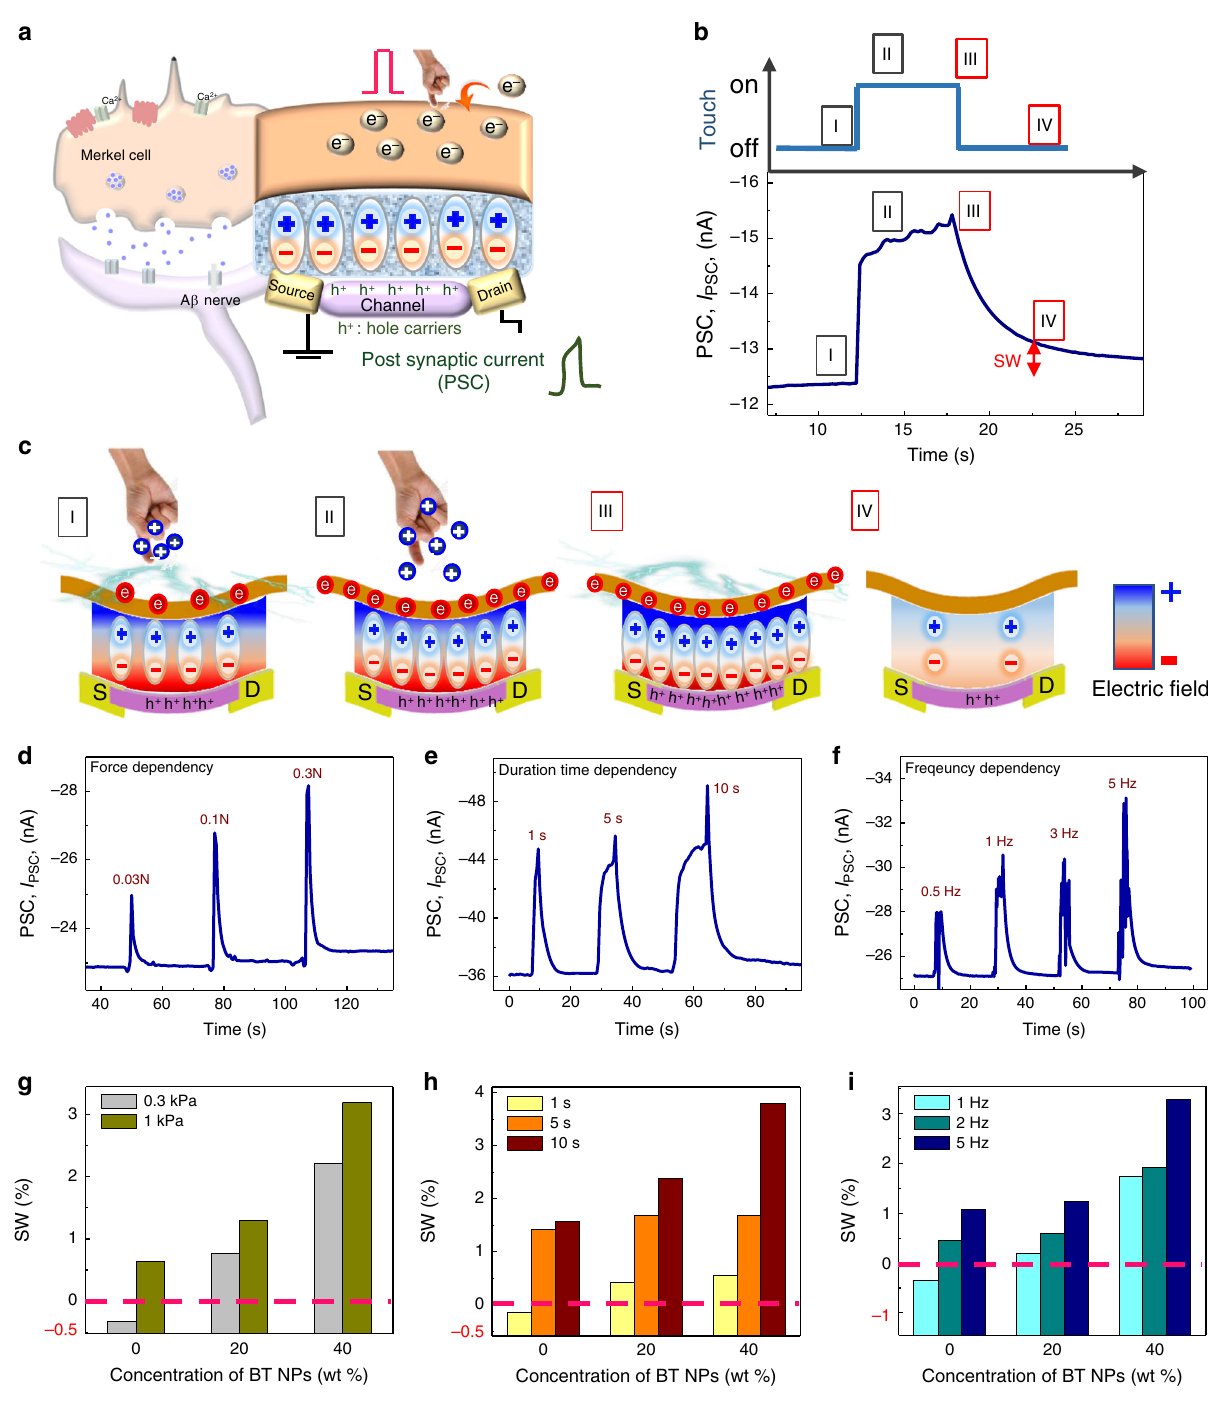
Fig. 3 Structure, mechanism, and synaptic properties of the AiS-TSO. a Sketch of device structure corresponding to a Merkel cell and MCNCs structure. b PSC during a tactile stimulus ( ≈ 0.3 kPa). A continuous bias of – 3 V was applied to the drain electrode to read the PSC. c Schematic explanation of dipole switching in the ferroelectric layer and accumulation of hole carriers in the channel induced by tactile stimulation. Illustration of the state of I – IV of b and principle of formation of P r with a change in channel conductance corresponding to SW. d Relative changes in the PSC of the AiS-TSO at different pressures. e Dependence of the PSC of the AiS-TSO on touch duration ( ≈ 1 kPa). f Dependence of the PSC of the AiS-TSO on touch rate ( ≈ 1 kPa for 5 s). g Relative changes in SW for different pressures and fractions of BT NPs in the ferroelectric nanocomposite. h Relative changes in SW for different durations of touch and fractions of BT NPs in the ferroelectric nanocomposite ( ≈ 1 kPa). i Relative changes in SW for different frequencies of touch and fractions of BT NPs in the ferroelectric nanocomposite ( ≈ 1 kPa). Pink dotted line g – i indicates arbitrary criteria for STP/LTP and noise fi ltering based on